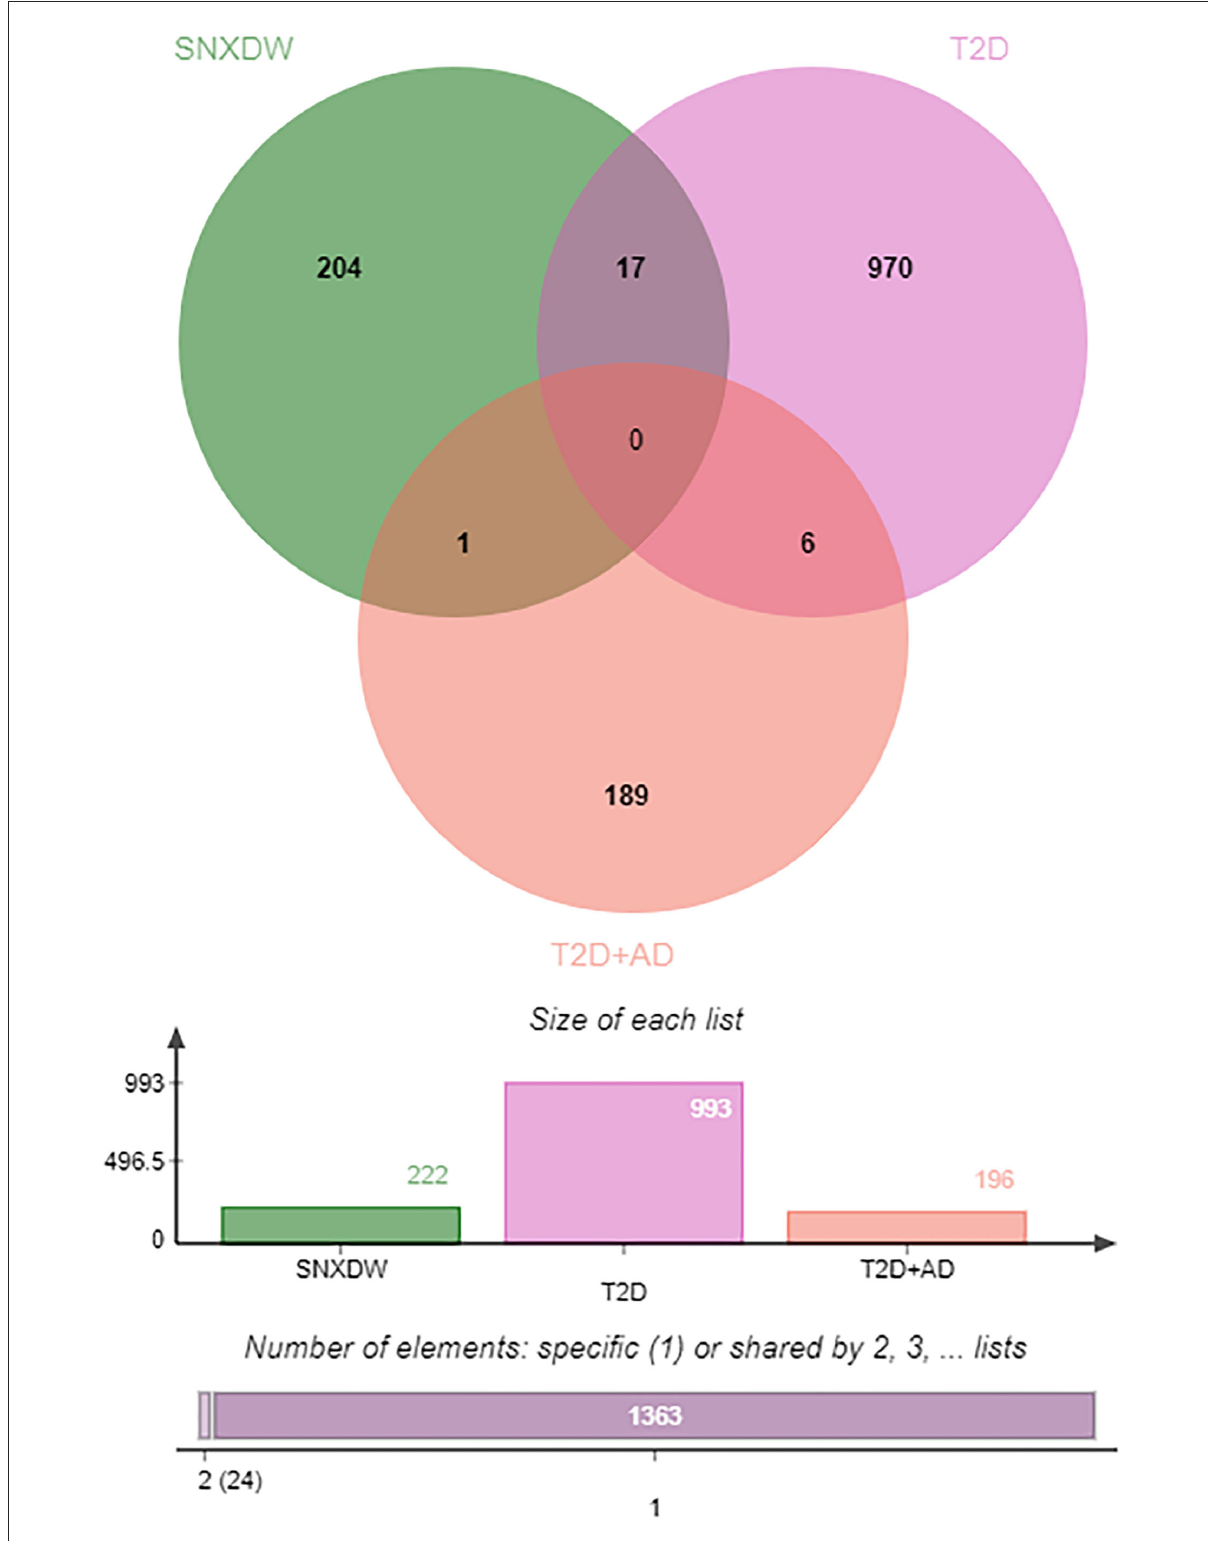
FIGURE3 Venn diagram of drug active ingredient-disease intersection